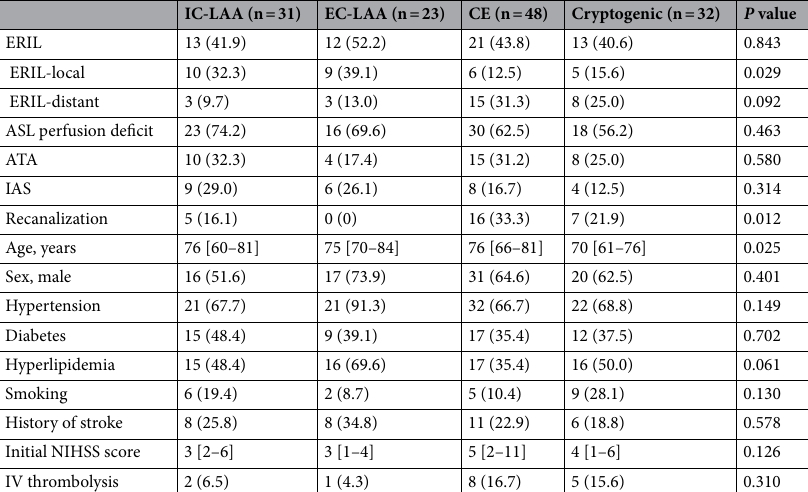
Table 4. Comparisons of baseline characteristics, ASL parameters, and ERIL according to stroke mechanisms. ASL arterial spin labeling, ERIL early recurrent ischemic lesion, IC-LAA intracranial large artery atherosclerosis, EC-LAA extracranial large artery atherosclerosis, CE cardioembolism, ATA arterial transit artifact, IAS intraarterial high-intensity signal, NIHSS National Institutes of Health Stroke Scale, IV